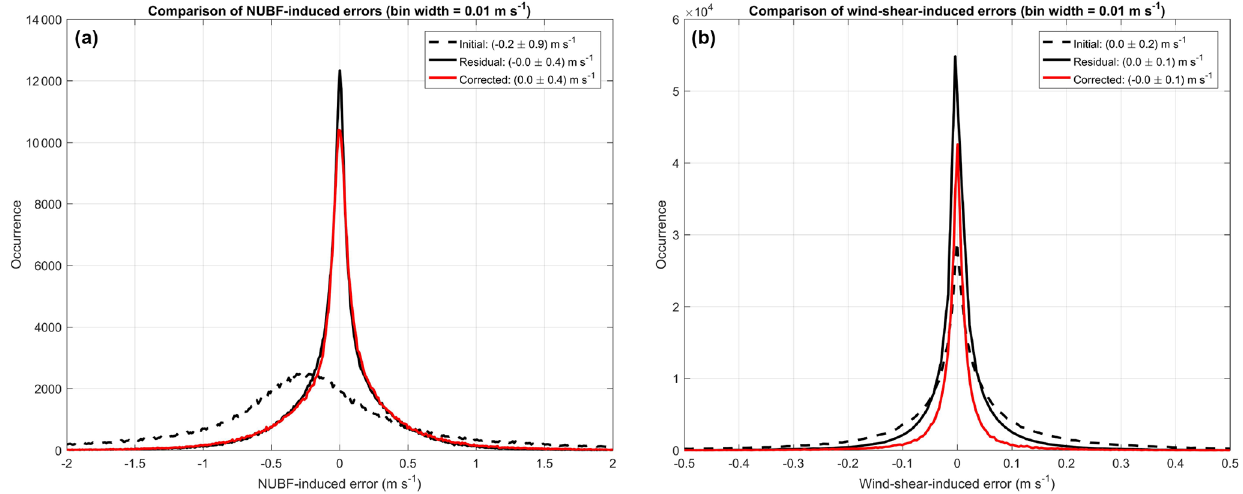
Figure 9. (a) Distribution of 8-day CloudSat data set NUBF-induced (wind-shear-induced) errors. Black dashed line is initial errors, black solid line is errors after correction with perfect measurements, red line is errors after correction with noisy measurements. A T hv = 20µs and a spectral Doppler width of 4ms − 1 have been assumed when including